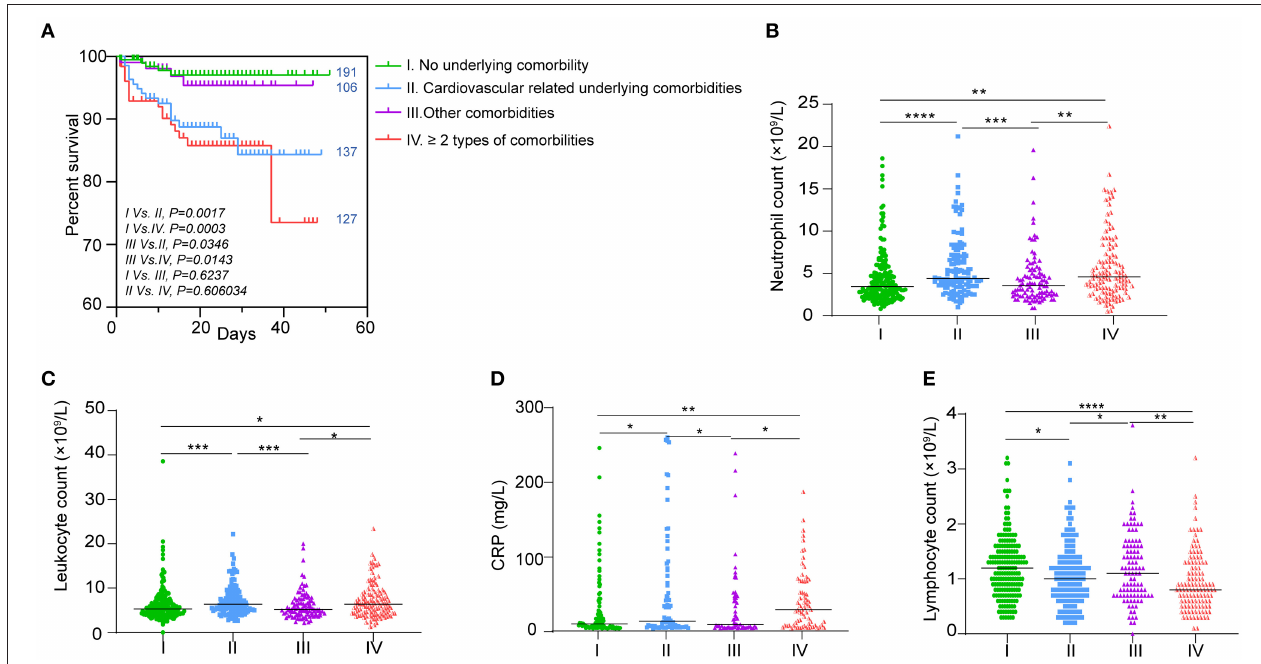
FIGURE 5 | Association of underlying comorbidities and hematologic indices. (A) Kaplan–Meier survival curves for different underlying comorbidities. The number of patients in each group is indicated next to the curve. Hematologic indices in the four groups that showed to be better fit the survival curves including (B) neutrophils, (C) lymphocytes, (D) leukocytes, and (E) CRP levels. Data are shown as dots with median lines. * P < 0.05, ** P < 0.01, *** P < 0.001, and **** P <